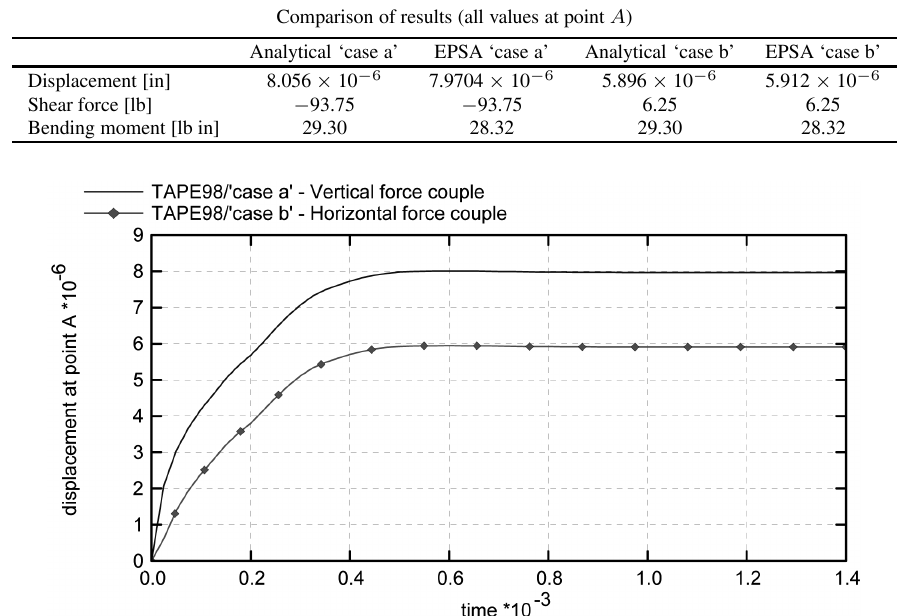
Fig. 6. Displacement time histories (units – [in]) for “case a” and “case b”. (Displacement at point A: w = w M + w Q ) The in fl uence of bending moments is almost identical for both “case a” and “case b.” This is to be expected, as